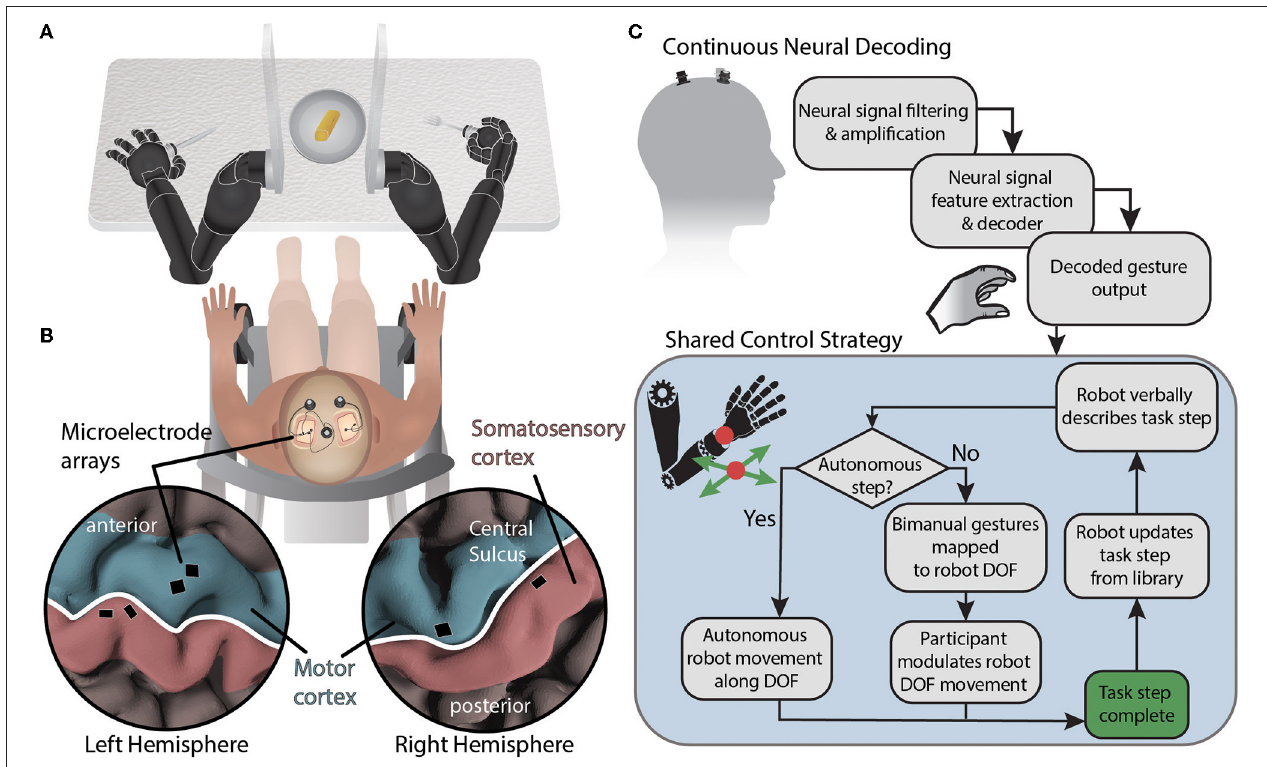
FIGURE 1 | System diagram for BMI-based shared control of bimanual robotic limbs. (A) Movements are decoded from neural signals through the brain-machine interface and mapped to two external robotic limbs while using a collaborative shared human-machine teaming control strategy to complete a self-feeding task requiring simultaneous bimanual manipulations. (B) NeuroPort electrode arrays (Blackrock Neurotech) implanted in the motor and somatosensory regions of the left and right hemispheres record neural activity. (C) Neural data is streamed from the cortical implants and processed before being decoded. Decoded gestures are passed to the shared control strategy for mapping onto robot degrees of freedom depending on the current state of the task. Autonomous portions of the task are performed by the robot while semi-autonomous steps are controlled in part by the participant using attempted gestures to modulate a subset of robotic limb end effector degrees of freedom using the current DOF mapping. The degrees of freedom controlled via BMI are based on a task library accessed by the